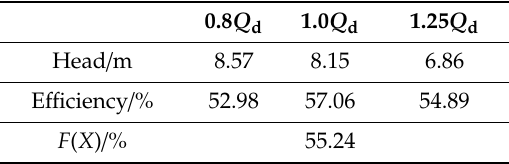
Table 12. Performance of optimized scheme (scheme 3).